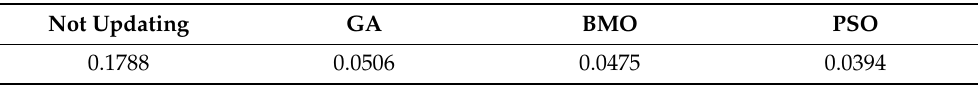
Table 7. Comparison of 2-norm of errors by using different model updating methods. Not